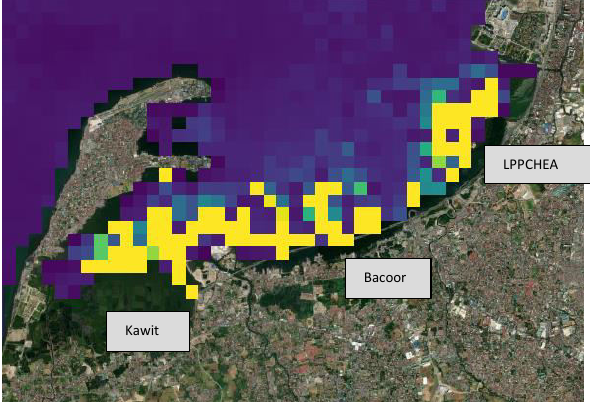
Figure 8. High CDOM areas near Bacoor-Kawit Bay area